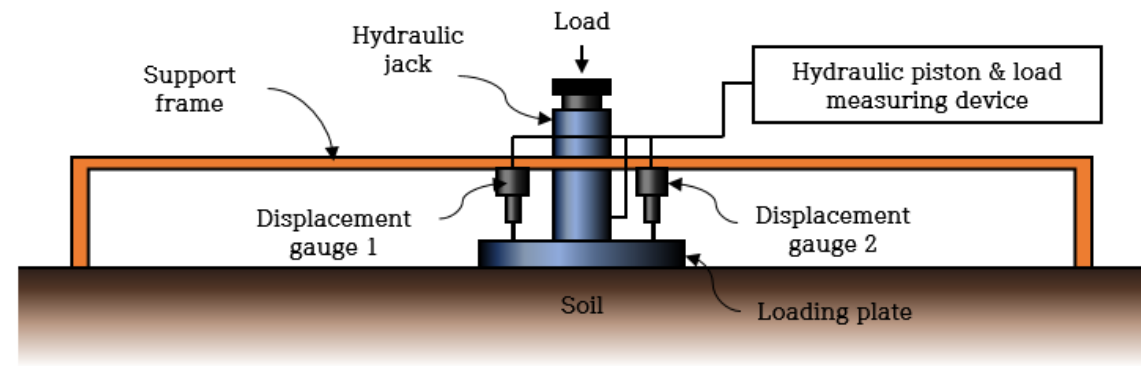
Figure 2. Plate Loading Test (PLT) equipment composition [33].